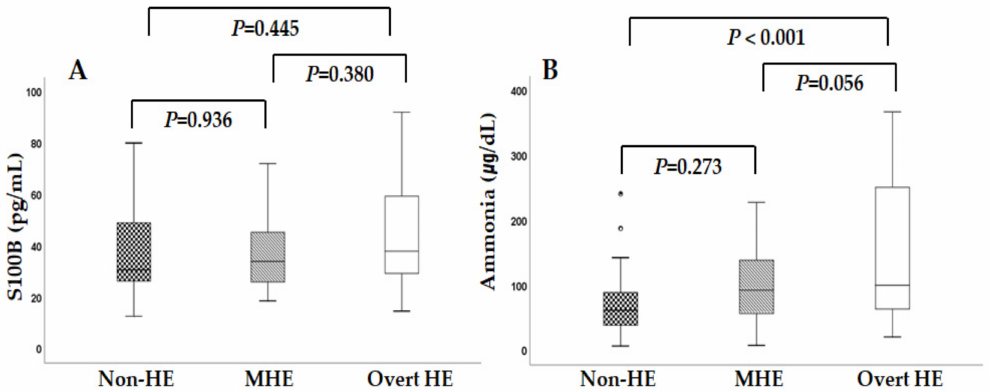
Figure 2. Comparision of serum S100B and ammonialevels according to the severity of HE; ( A ): There was no significance differences in serum S100B among the three groups. ( B ): Serum ammonia levels showed significant difference only between the overt HE group and the non‑HE group.